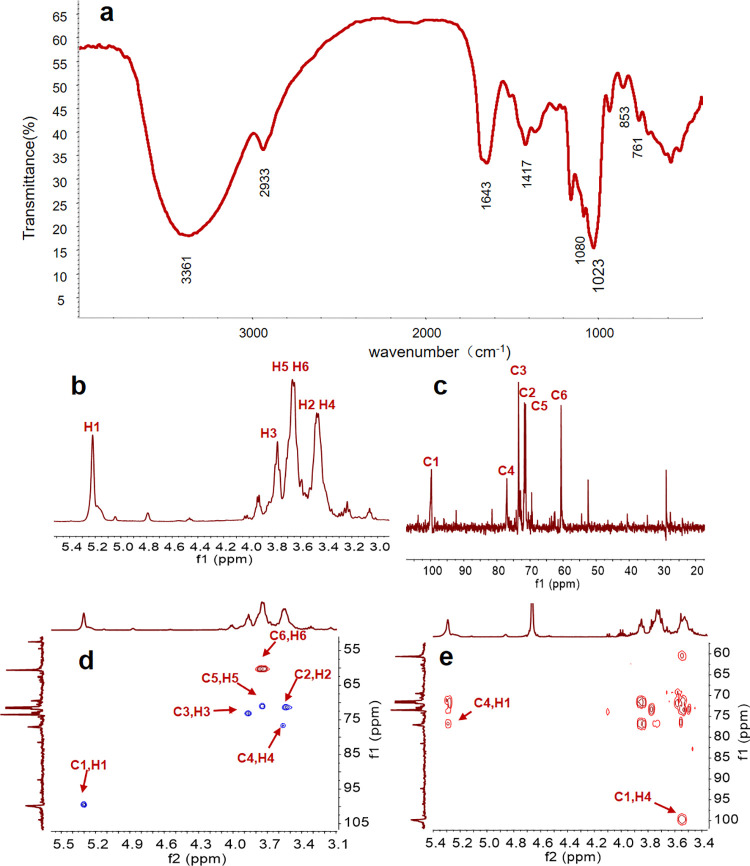
The FT-IR and NMR analysis.(a) FT-IR spectrum of AP. (b) 1H-NMR spectrum of AP. (c) 13C-NMR spectrum of AP. (d) 1H-13C HSQC spectrum of AP. (e) 1H-13C HMBC spectrum of AP.